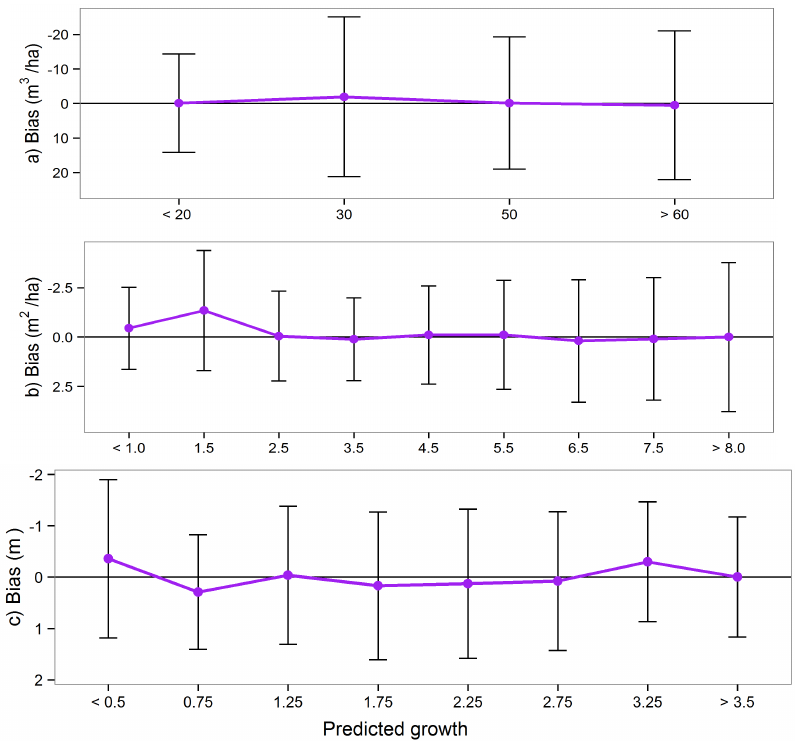
Figure A1. Mean residuals (Bias) and standard deviation (SD) in different classes of predicted growth for the different growth models, ( a ) V i (stem volume growth); ( b ) BA i (basal area growth), and ( c ) H i (Lorey’s mean height growth), for spruce stands.